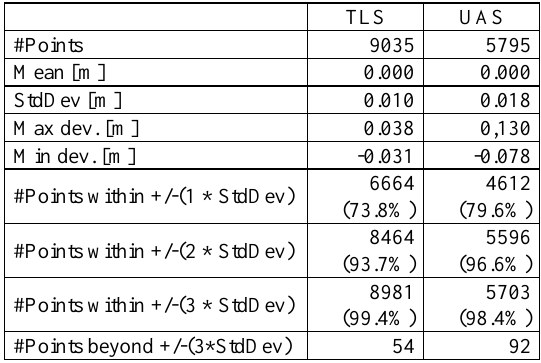
Table 3. Deviations of both surfaces with respect to the adjusted